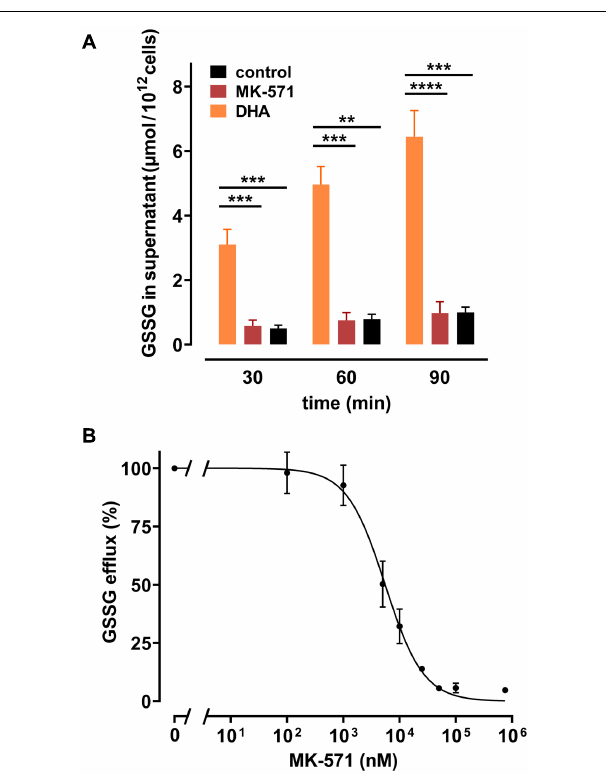
FIGURE 5 | Multidrug resistance protein (MRP) 1/4 inhibitor MK-571 blunts DHA-induced GSSG efflux. (A) Erythrocytes ( n = 5) were incubated with 2 mM DHA in the absence (orange) or presence (red) of 100 µ M of the multidrug resistance protein (MRP1/4) inhibitor MK-571 for 15 min at RT. Control incubations were performed in PBS (black). Cells were then washed and further incubated in PBS (black and orange) or PBS containing 100 µ M MK-571 (red). Abundance of GSSG in the supernatant was assessed at indicated timepoints by an enzymatic assay, as described in the section “Materials and Methods”. (B) Erythrocytes ( n = 5) were treated with 2 mM DHA and various concentrations of MK-571 for 15 min at RT. After incubation, cells were washed and further incubated in PBS containing the respective concentrations of MK-571 for 90 min. GSSG efflux data were normalized to respective controls (pre-treatment with 2 mM DHA in PBS - 100%; PBS control cells - 0%, respectively).